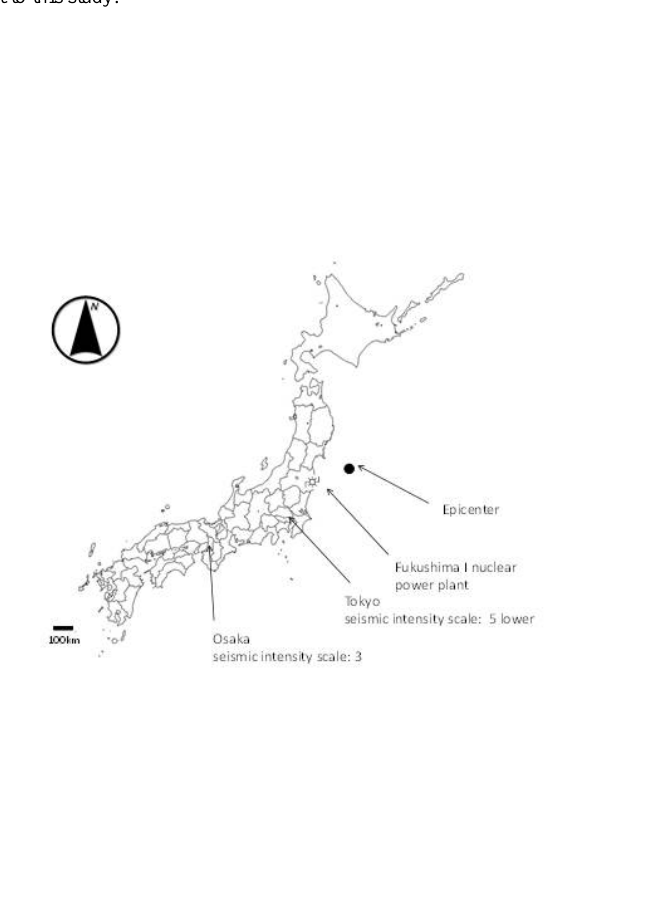
Figure 1. Map of the locations relevant to this